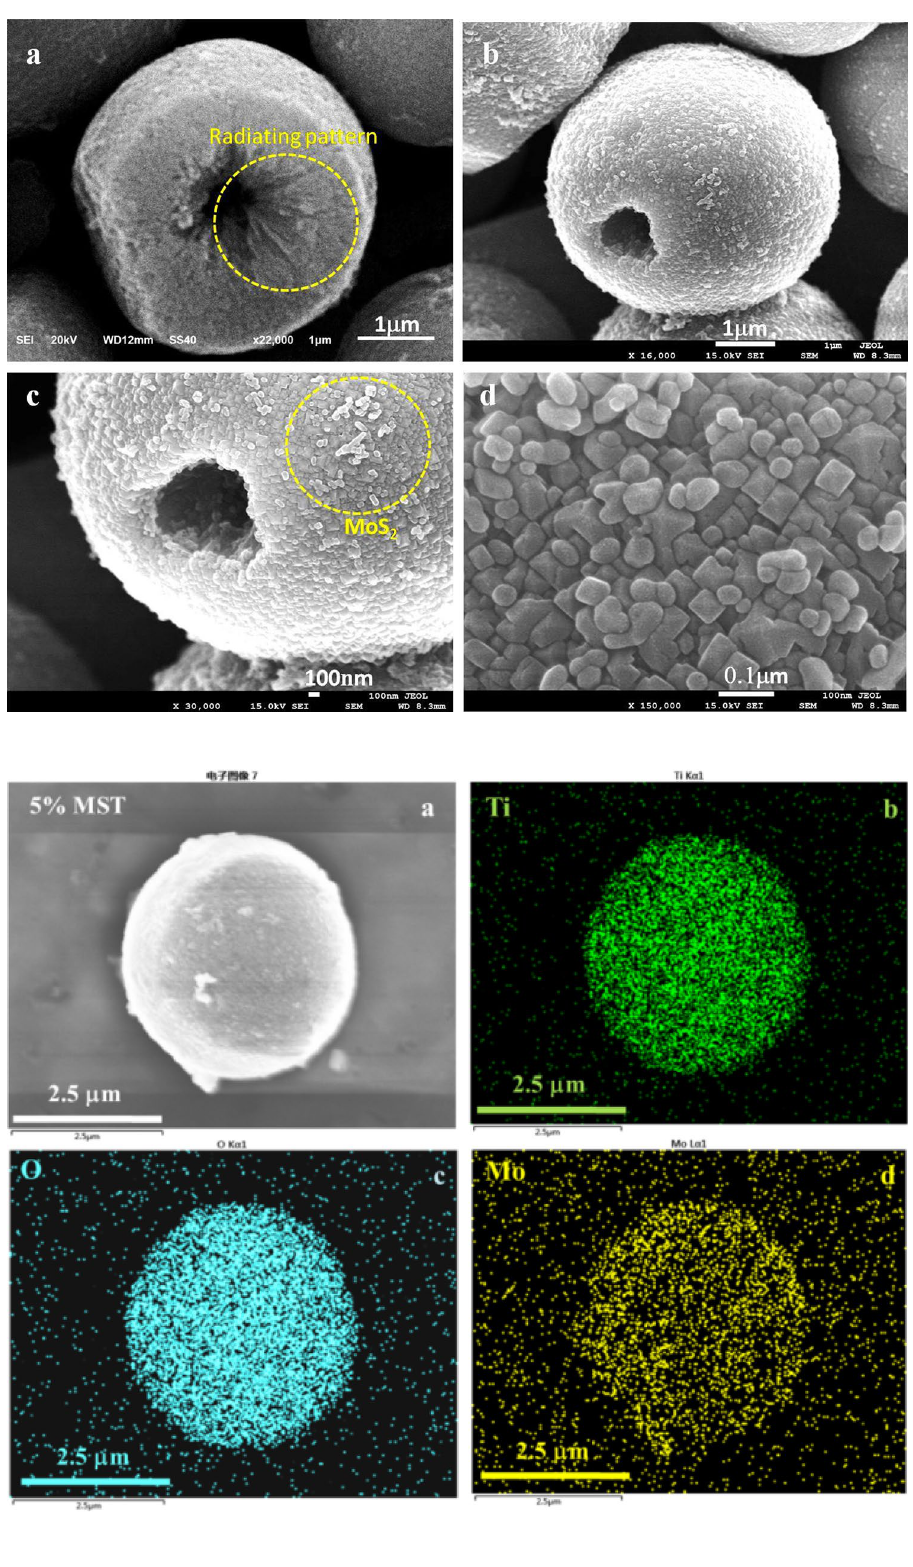
Fig. 2 SEM and FESEM micro- graph of MoS 2 -deposited TiO 2 hollow microspheres